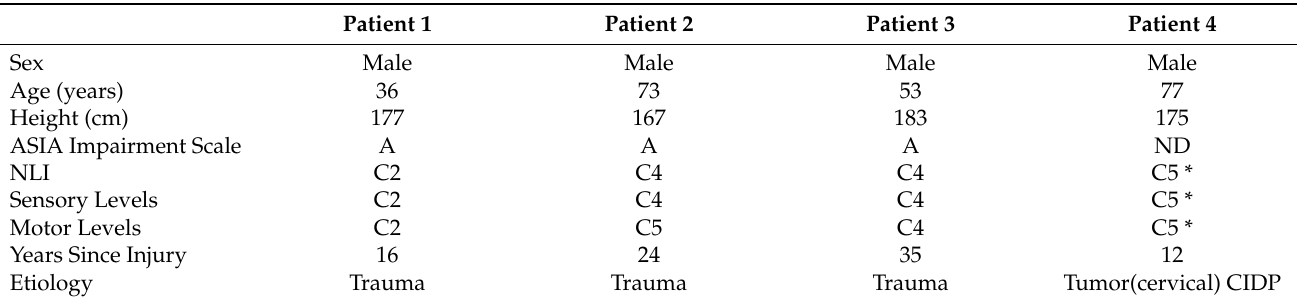
Table 2. Patient characteristics.